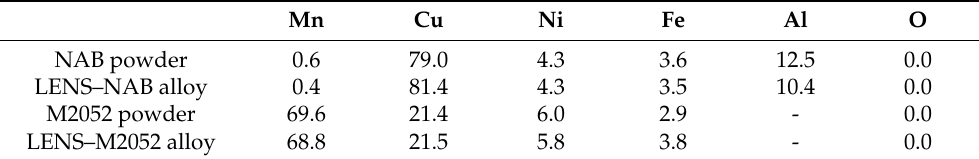
Figure 1. Particle morphologies of ( a ) M2052 and ( b ) NAB. Table 1. Chemical compositions (mass%) of M2052–NAB powder and M2052–NAB alloy prepared by LENS.